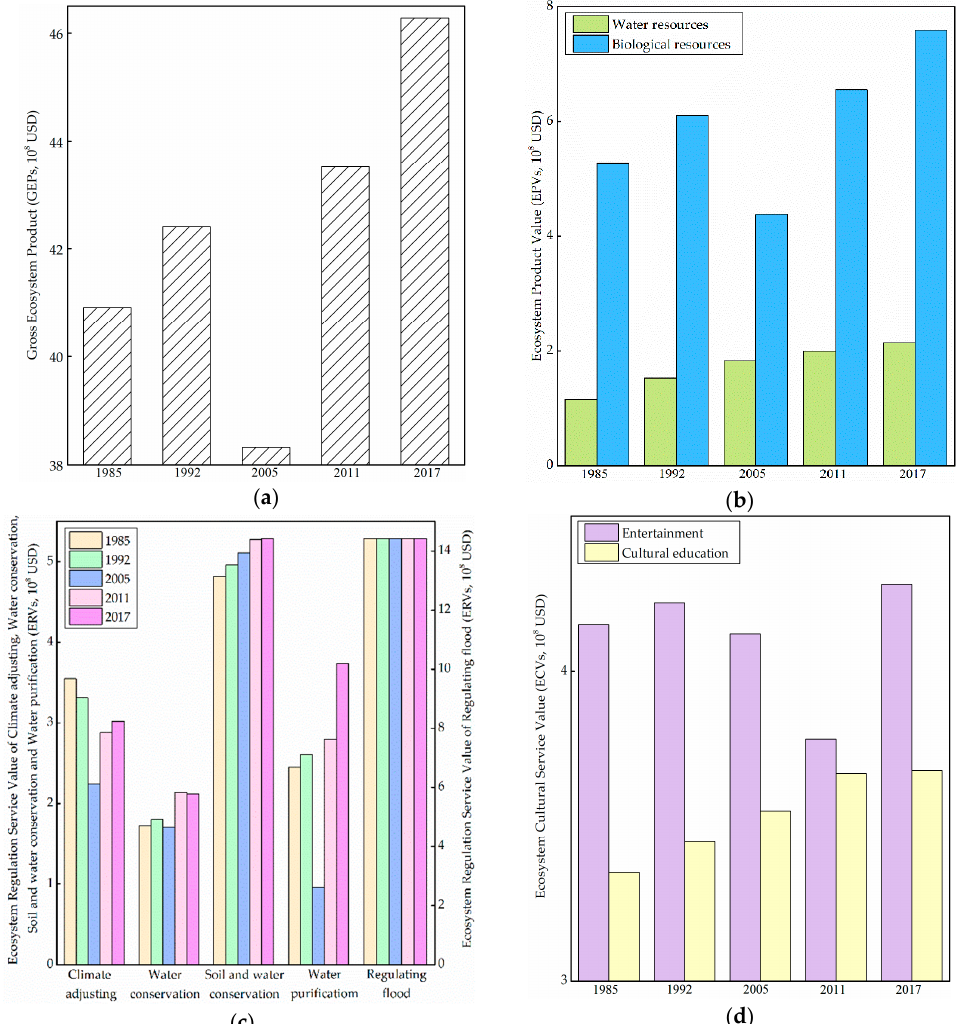
Figure 3. Variations of the gross ecosystem product in the Nansi Lake Wetland. ( a ) Gross Ecosystem Product, GEPs; ( b ) Ecosystem Product Value, EPVs; ( c ) Ecosystem Regulation Service Value, ERVs; ( d ) Ecosystem Cultural Service Value, ECVs.